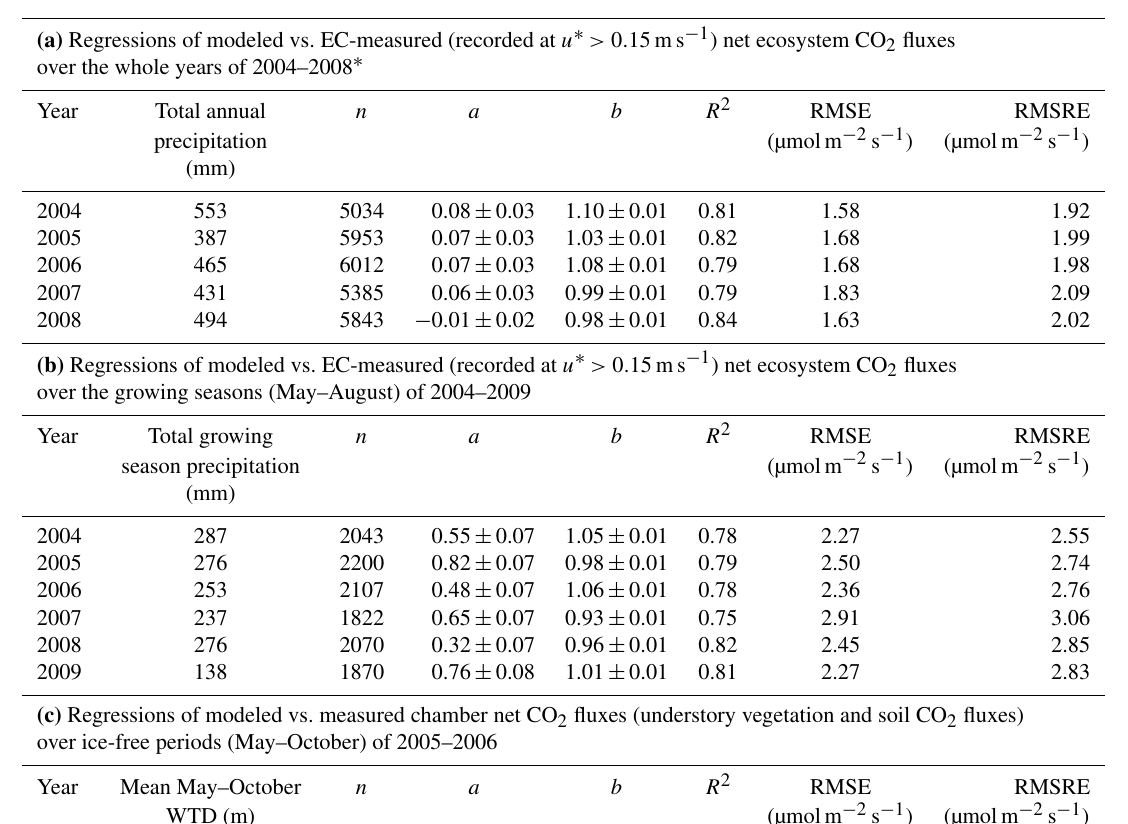
Table 1. Statistics from regressions between hourly modeled and measured net CO 2 fluxes from 2004 to 2009 at a western Canadian fen peatland.